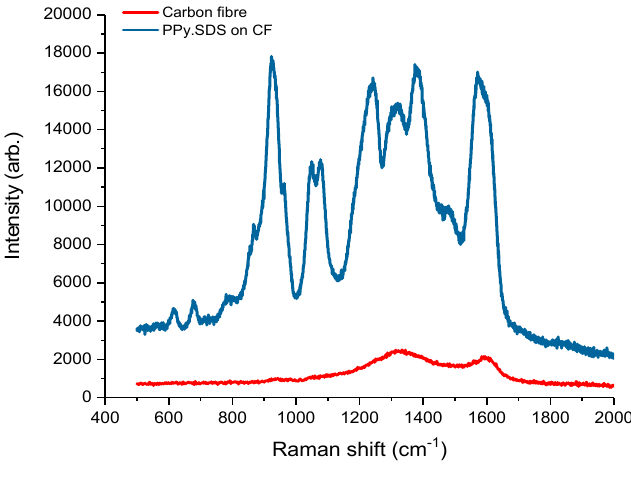
Figure 2. Raman spectrum of uncoated carbon fibre (red line) and PPy.SDS coated carbon fibre (blue